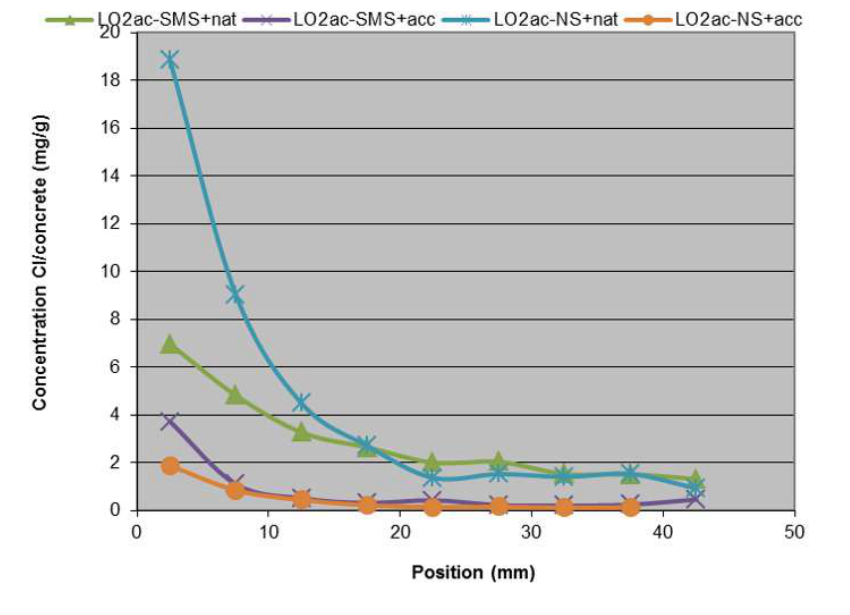
Figure 7. Concentration of chloride ions Low quality concrete, Natural